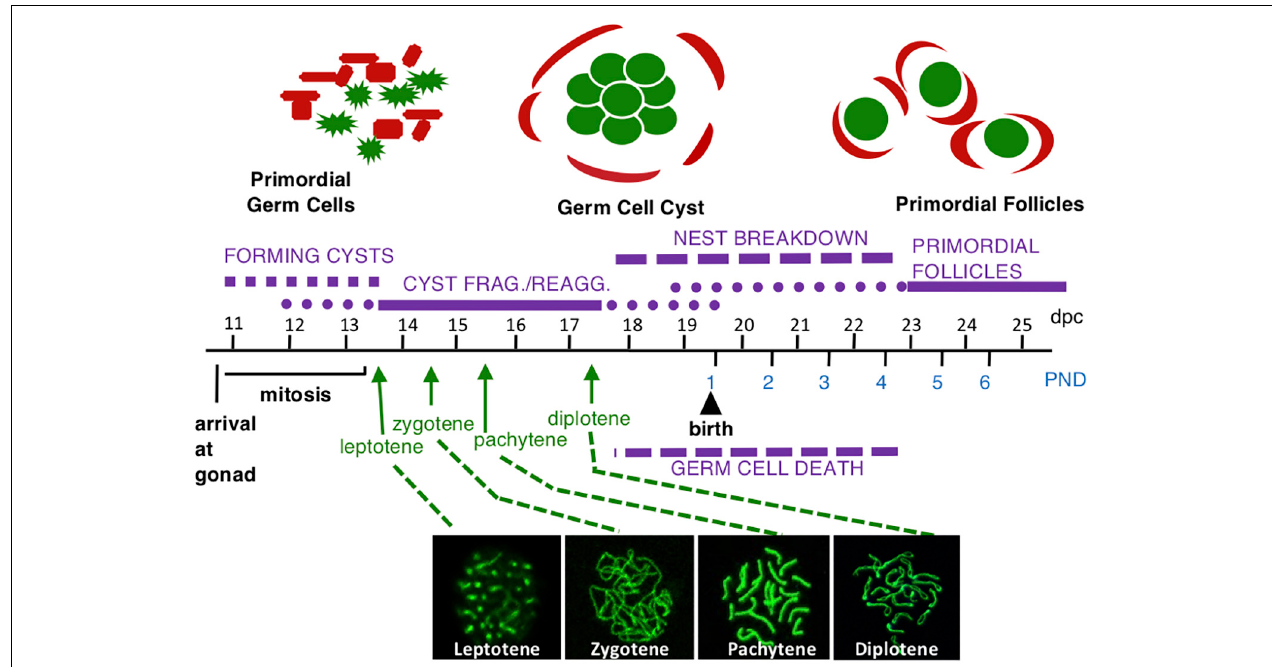
FIGURE 1 | Mouse female germ cell development. Germ cells are shown in green and somatic cells are shown in red above timeline. At 10.5 dpc, germ cells migrate to the gonad and begin rapidly dividing by mitosis, forming germ cell cysts. Some cysts fragment into smaller cysts and reassociate with unrelated cysts to form nests where some cells are still connected by intercellular bridges with others associated by aggregation. Beginning at 13.5 dpc, oogonia enter meiotic prophase one to become oocytes and progress through meiotic prophase one substages: leptotene, zygotene, pachytene, and diplotene (with representative surface spread nuclei labeled with SYCP3 in green shown below the timeline). The arrow for each substage indicates the first day oocytes are found in the indicated substage. Oocytes are found in each substage for several days. The oocytes arrest at the diplotene stage starting at 17.5 dpc. At this time, germ cell nests begin to breakdown and oocytes that are not lost due to apoptosis are surrounded by somatic cells forming primordial